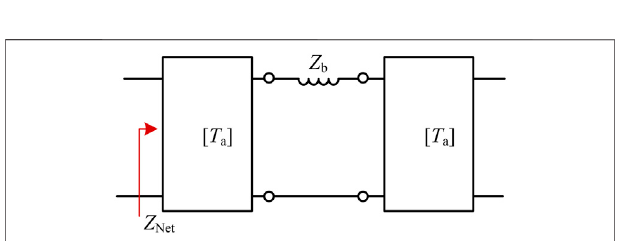
FIGURE 2 | Network manifestation with cascaded